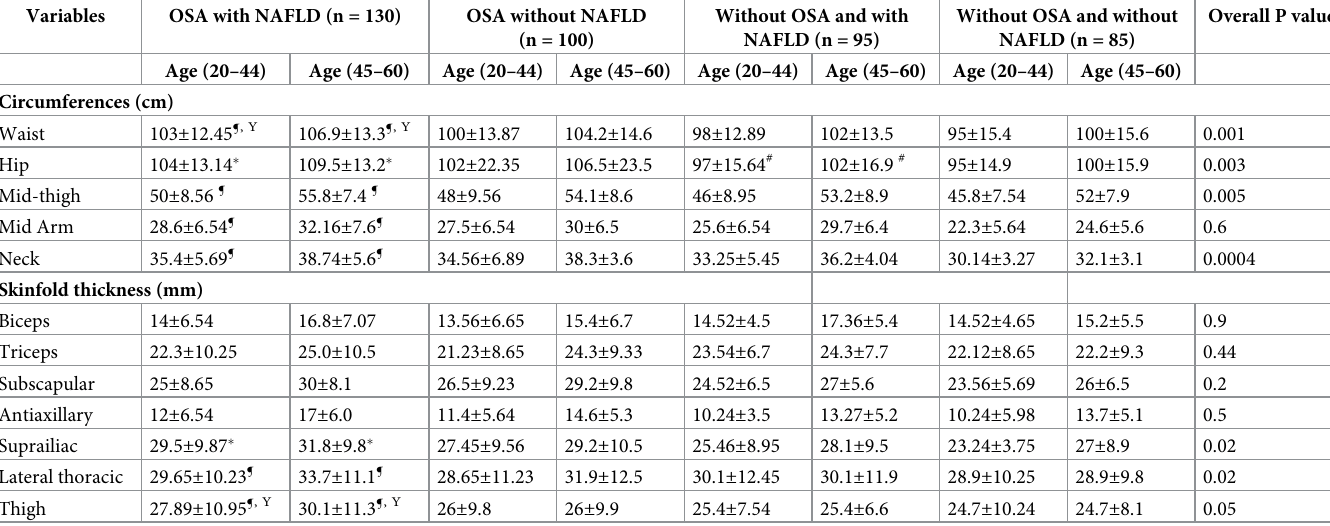
Table 2. Anthropometry